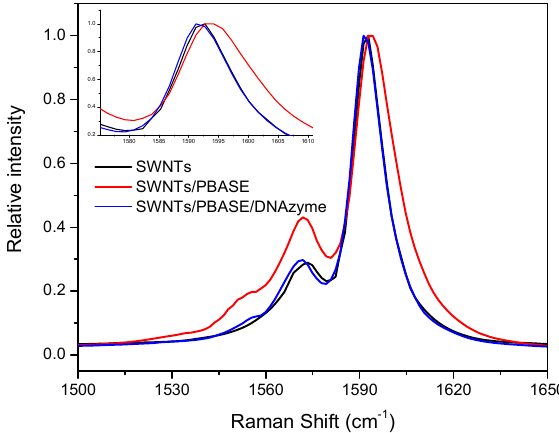
Figure 5. Raman spectra of SWNTs functionalized with PBASE and DNAzyme.